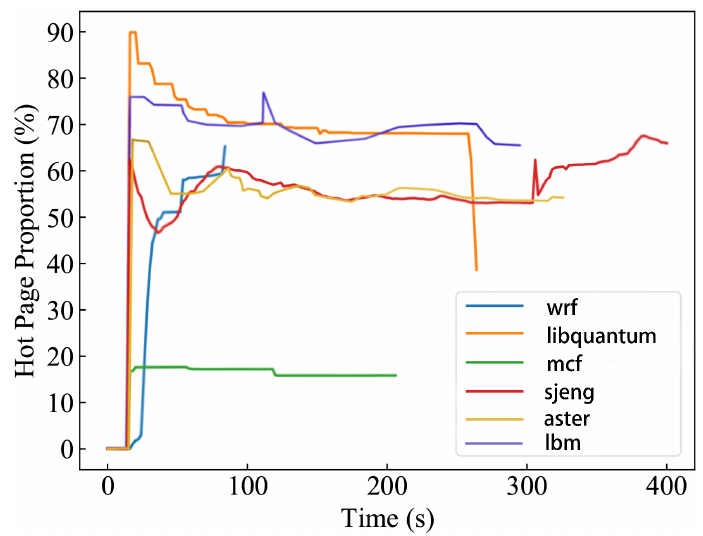
Figure 8. The proportion of hot pages identified in SPEC